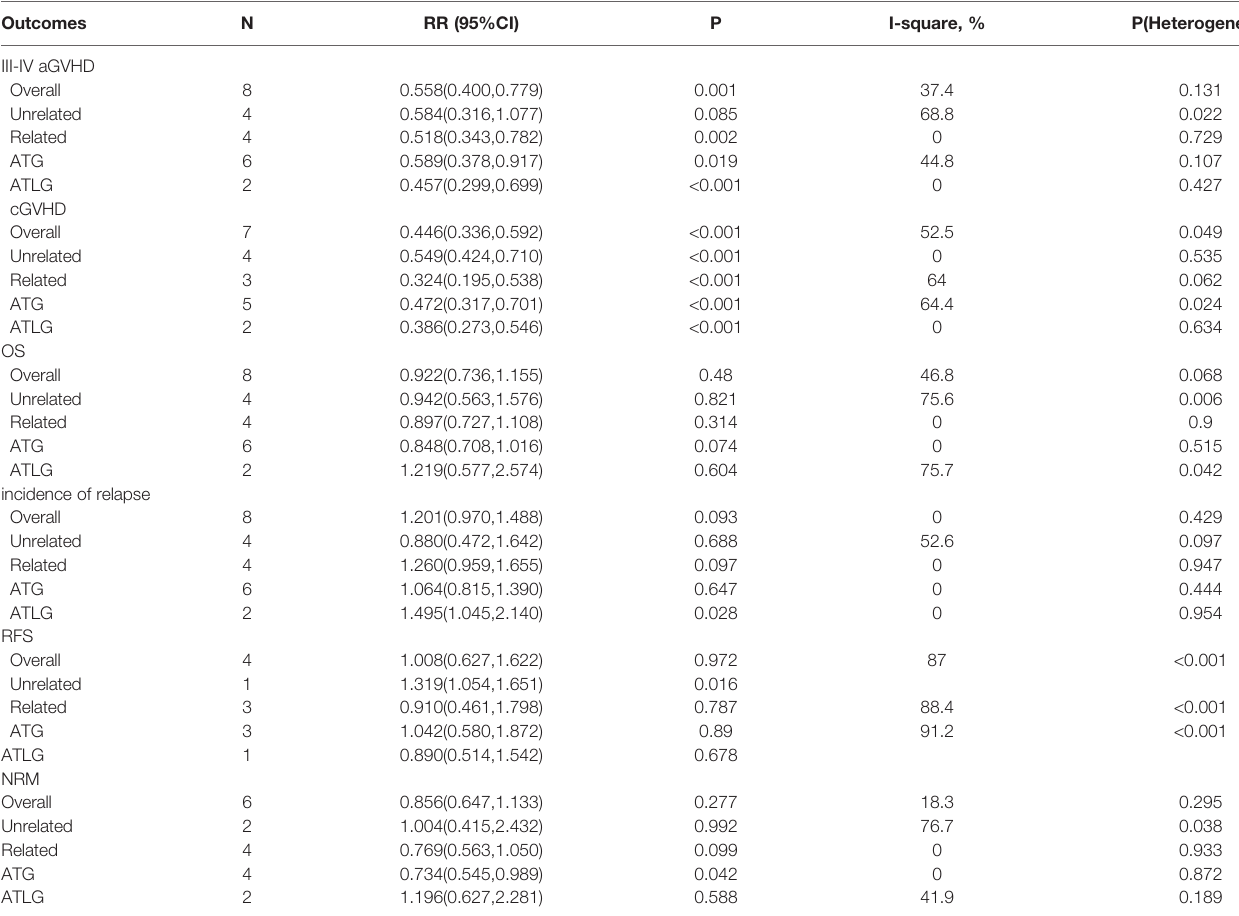
TABLE 2 | Summary of subgroup